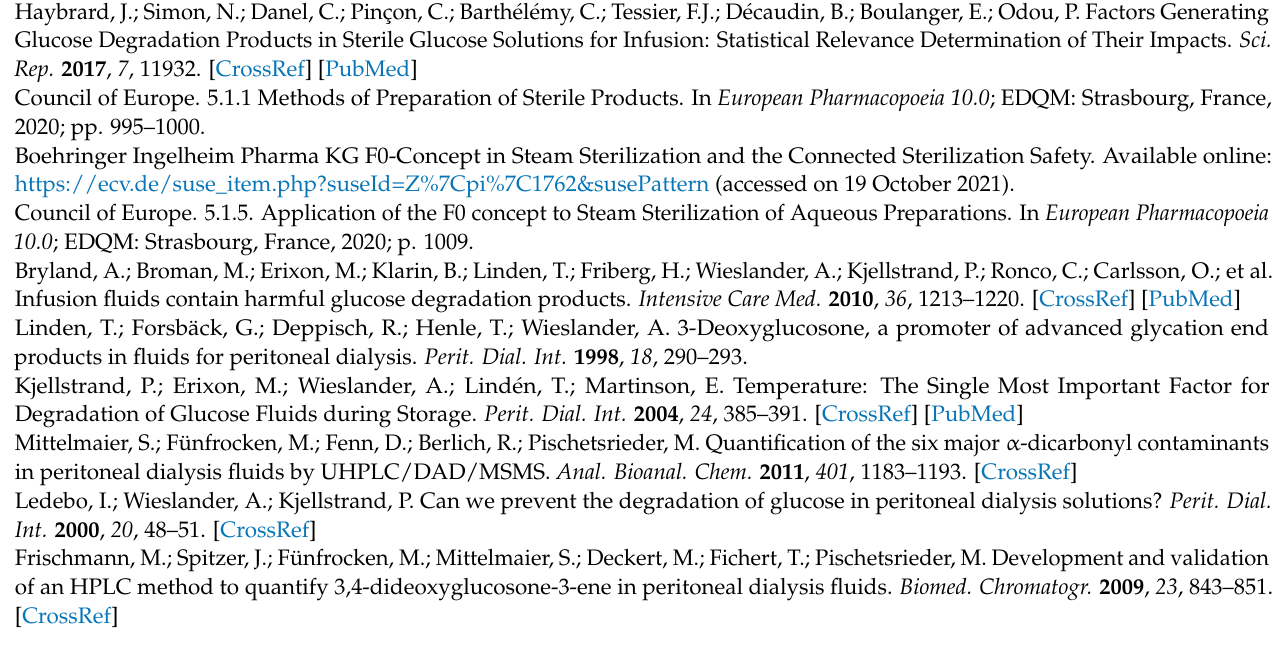
at 111 ◦ C, 116 ◦ C, and 121 ◦ C autoclaved according to scheme A ( n = 27), Figure S6: Concentrations of 3,4-DGE after heat sterilization of 10% glucose solutions at 111 ◦ C, 116 ◦ C, and 121 ◦ C autoclaved according to scheme A ( n = 27), Figure S7: Concentrations of 5-HMF after heat sterilization of 10% glucose solutions at 111 ◦ C, 116 ◦ C, and 121 ◦ C autoclaved according to scheme A ( n = 27), Figure S8: Concentrations of GO after heat sterilization of 10% glucose solutions at 111 ◦ C, 116 ◦ C, and 121 ◦ C autoclaved according to scheme B ( n = 27), Figure S9: Concentrations of MGO after heat sterilization of 10% glucose solutions at 111 ◦ C, 116 ◦ C and 121 ◦ C autoclaved according to scheme B ( n = 27), Figure S10: Concentrations of 2-KDG after heat sterilization of 10% glucose solutions at 111 ◦ C, 116 ◦ C, and 121 ◦ C autoclaved according to scheme B ( n = 27), Figure S11: Concentrations of 3-DG/3- DGal after heat sterilization of 10% glucose solutions at 111 ◦ C, 116 ◦ C, and 121 ◦ C autoclaved according to scheme B ( n = 27), Figure S12: Concentrations of 3,4-DGE after heat sterilization of 10% glucose solutions at 111 ◦ C, 116 ◦ C, and 121 ◦ C autoclaved according to scheme B ( n = 27), Figure S13: Concentrations of 5-HMF after heat sterilization of 10% glucose solutions at 111 ◦ C, 116 ◦ C, and 121 ◦ C autoclaved according to scheme B ( n = 27), Figure S14: Concentrations of GDPs in 10% ( w / v ) glucose solutions in PP bottles heat sterilized at 121 ◦ C for 350 min (F0 = 202 min) ( n =